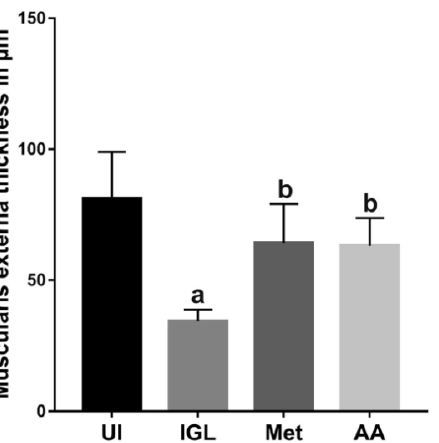
Figure 10. Treatment with A. annua reversed the pathological effect of G. lamblia infection on muscularis externa thickness. Infection of hamsters with G. lamblia (IGL) significantly decreased the muscularis externa thickness compared to uninfected animals (UI). Treatment of infected hamsters with A. annua extract (AA) significantly increased the muscularis externa thickness compared to infected untreated animals, an effect which was comparable to that after metronidazole treatment (Met). ( a ) indicates significant difference versus UI group. ( b ) indicates significant difference versus IGL group ( p < 0.001). Data are expressed as means ± SD (n = 3) and were analyzed using ANOVA test with Bonferroni corrections as a post hoc test.